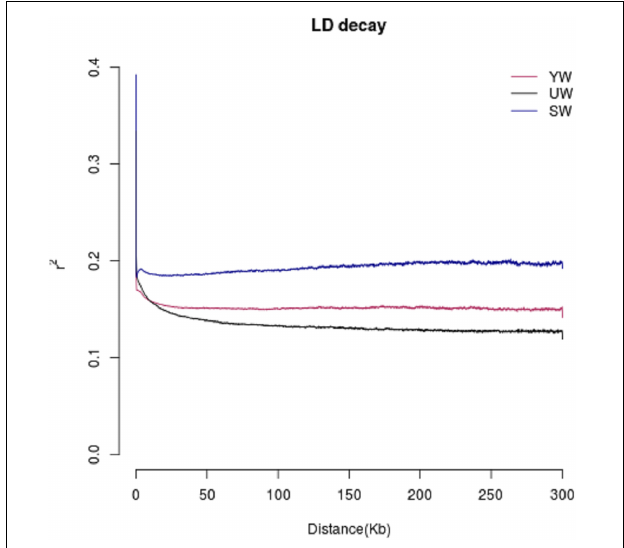
FIGURE 4 | Linkage disequilibrium (LD) analysis of different G. uralensis populations. The abscissa indicates the distance at which linkage disequilibrium occurs, ordinate is linkage disequilibrium coefficient.